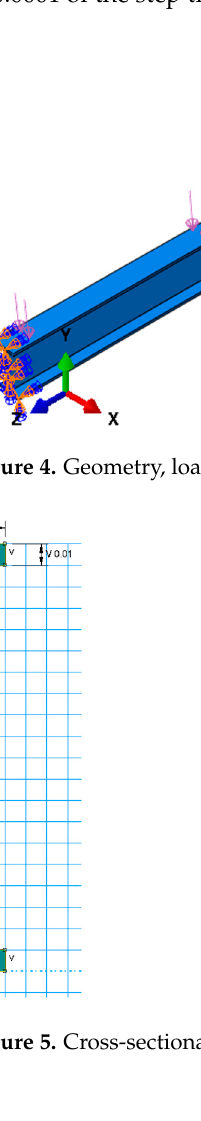
Figure 6. ISO-Standard fire curve (left graph) and fire scenario (right graph). Figure 7. Thermal boundary conditions.